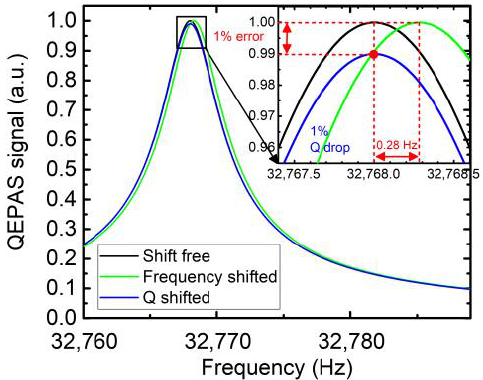
Figure 1. The frequency response of the shift-free QEPAS signal (black) is represented. It is a Lorentzian curve centered at 32,768 Hz, having a quality factor of 8000. The QEPAS signal reaches a maximum value at f = f 0 . The frequency response is also shown for a frequency shift of 0.28 Hz (green) and Q-factor reduction of 80 (blue). The two curves intersect (red dot) at f = f 0 , corresponding to a 1% QEPAS signal error as